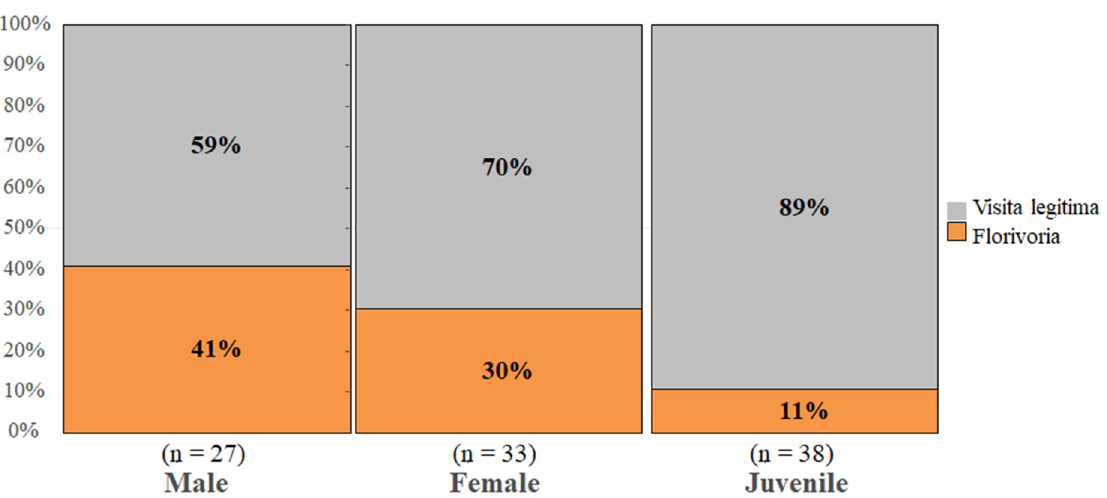
Figure 3. Relationship between the type of the interaction (legitimate visit vs. florivory) according to sex and age of lizards. Grey areas correspond to legitimate visits, while orange areas correspond to florivory.